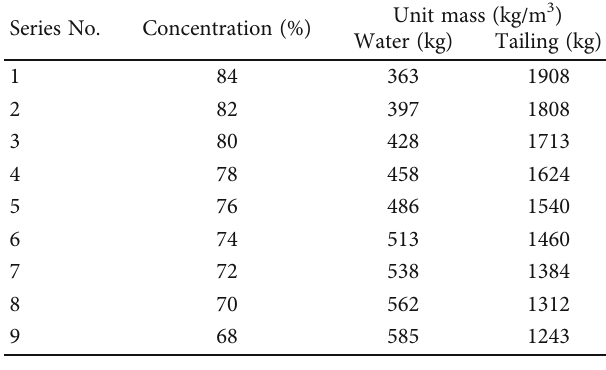
Table 3: Proportion of tailing slurry. Series No.